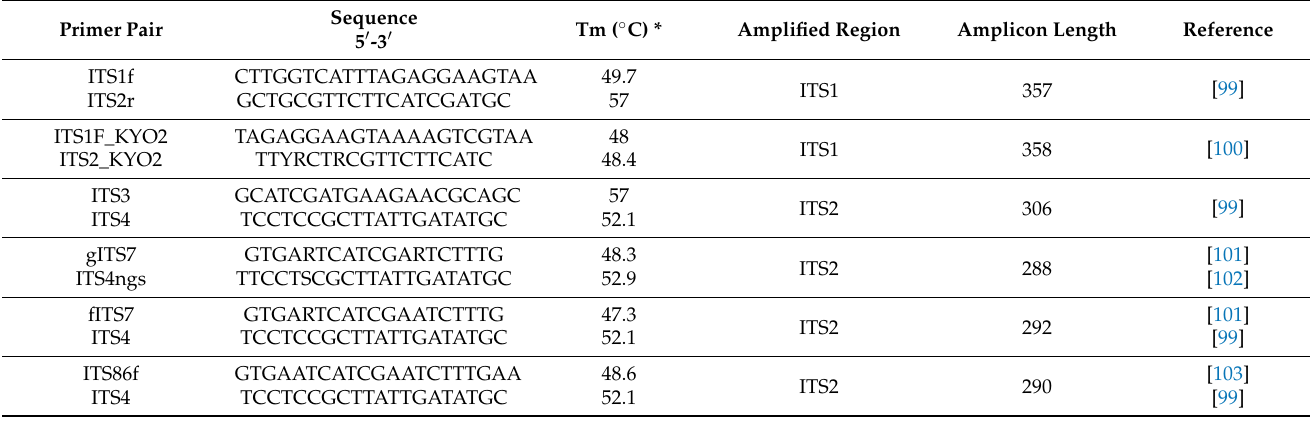
Table 4. Primer pairs targeting the ITS region that have been frequently used to characterize fungal biodiversity in studies based on Illumina